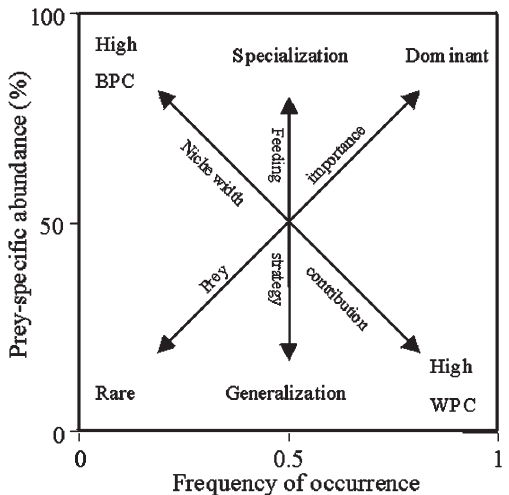
Fig. 2. – Modified Costello graph showing explanatory axes (modified from amundsen et al .,